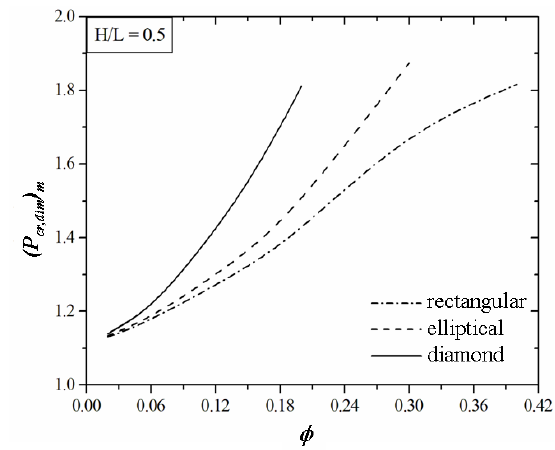
Figure 12. Theoncemaximizeddimensionlesscriticalbucklingload ( P cr,dim )m as a function of the hole volume fraction φ for all hole shapes.